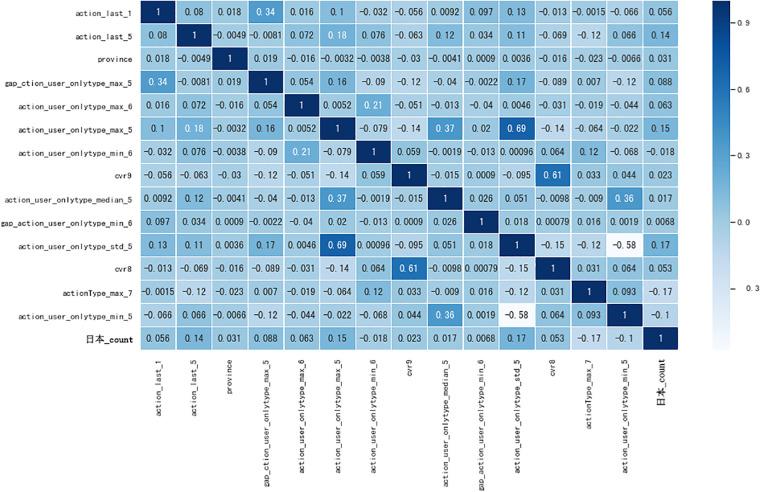
Characteristic correlation heat map.